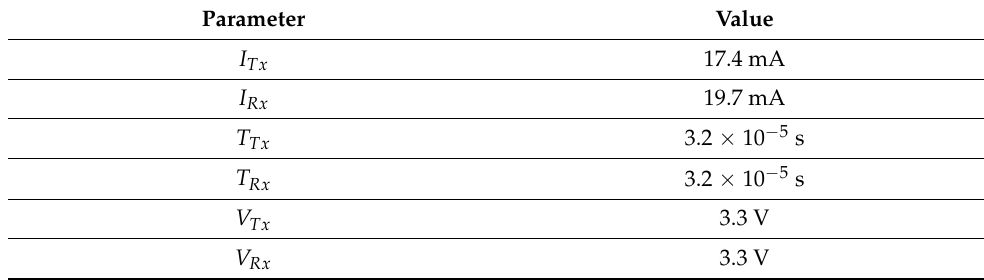
Table 6. The power consumption of wireless module .